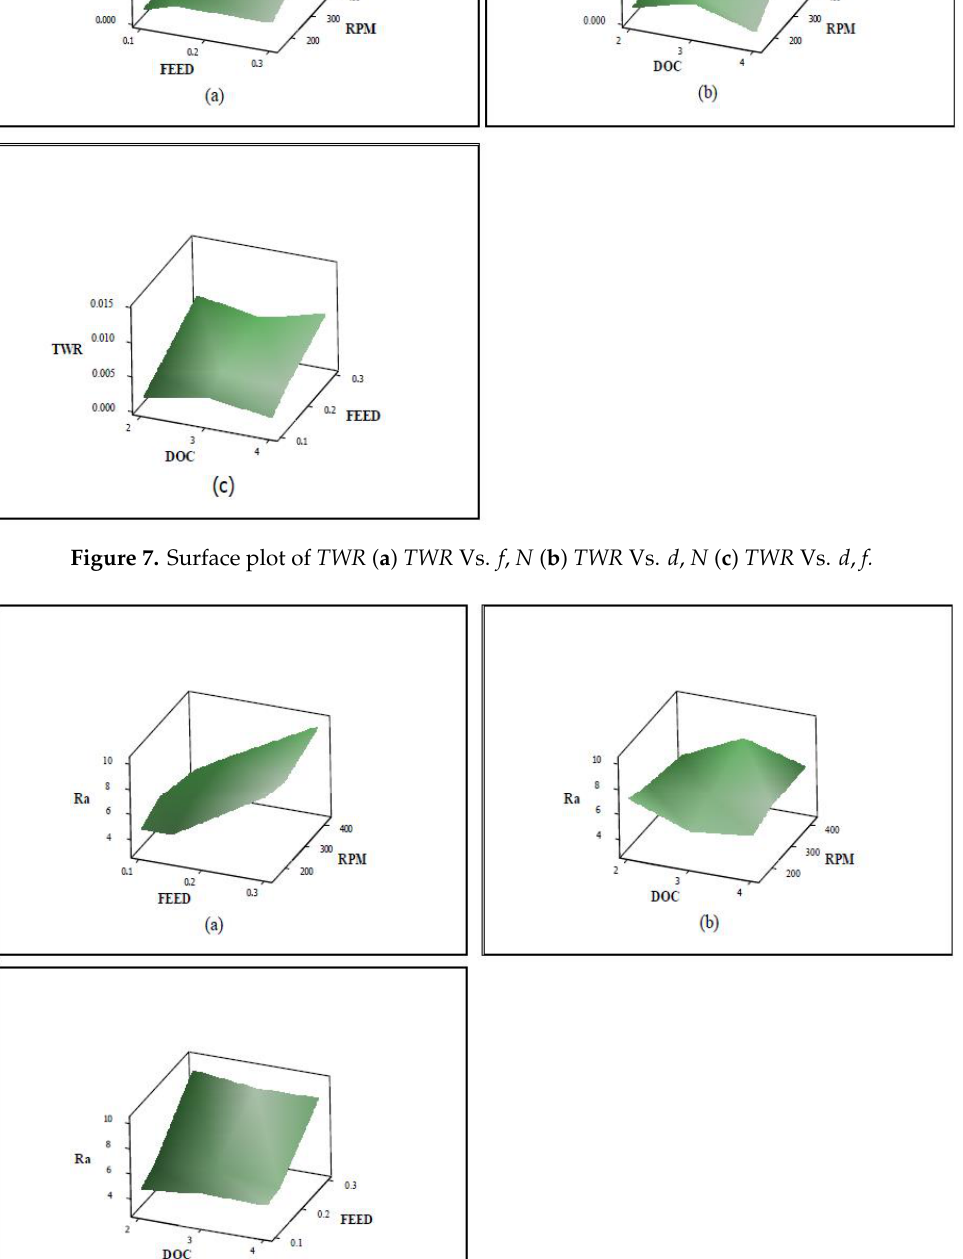
Table 10. Training result for hidden layer 1.